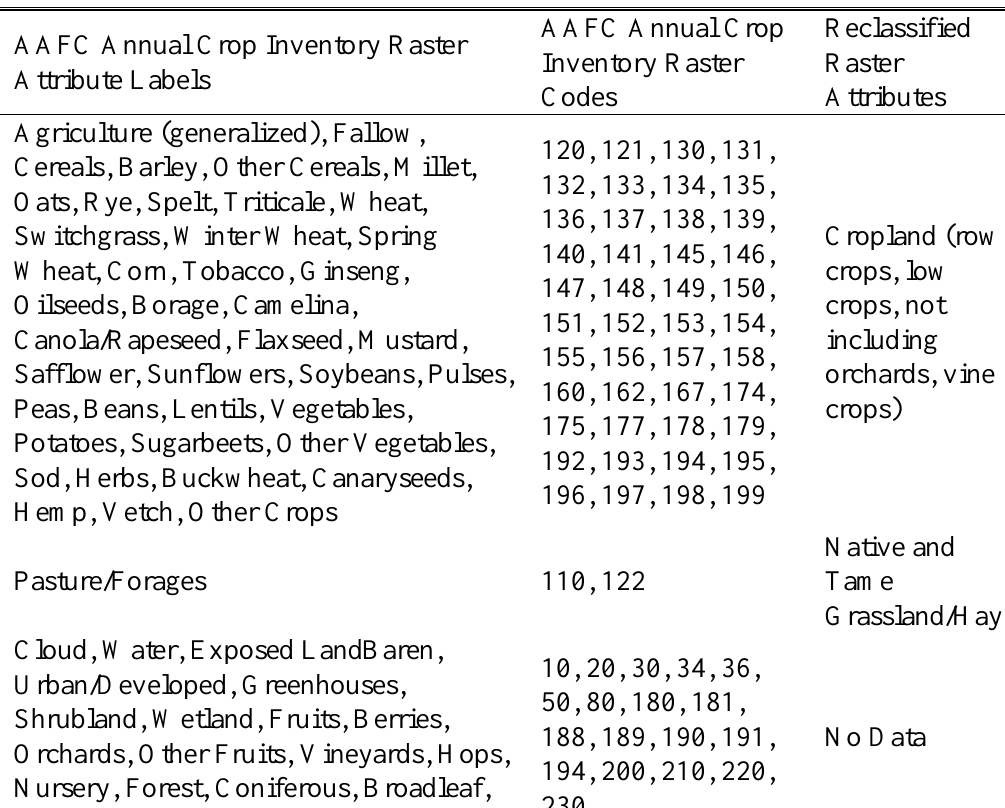
Table A2.1. Reclassification table for converting Agriculture and Agri-Food Canada (AAFC) Annual Crop Inventory 1 land cover classifications into two land cover types differentially used by grassland songbirds: cropland, and native and tame